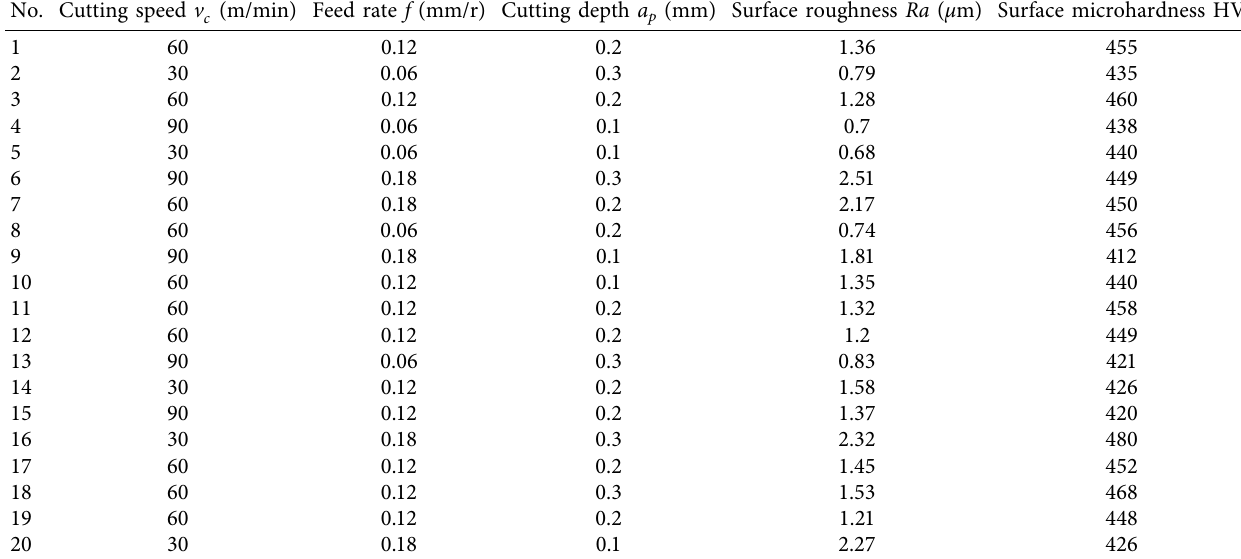
Table 4: The response surface experimental results.